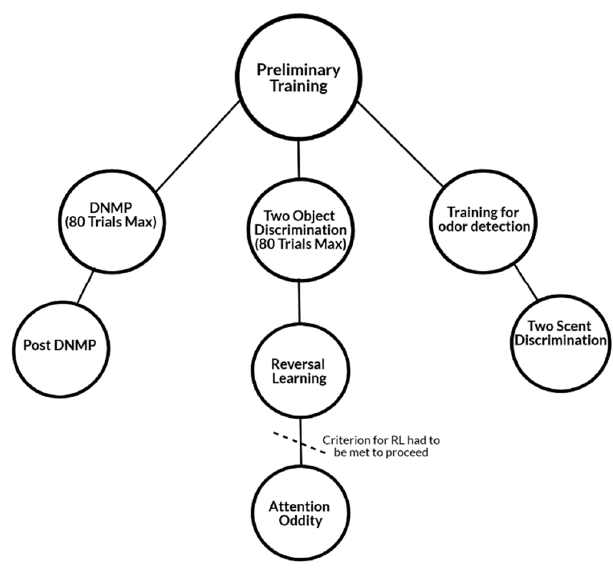
Figure 3. Study design flow chart showing the sequence in which cognition tests were administered. Delayed non-match to position (DNMP), visual, and scent discrimination were frequently run concurrently.